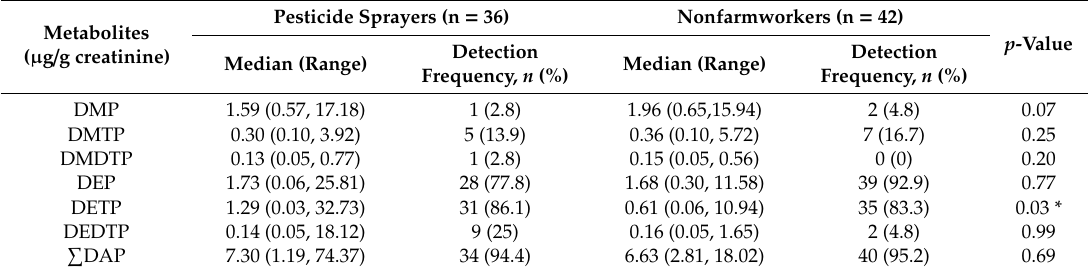
Table2. DAPlevels( µ g / gcreatinine)anddetectionfrequencyinpesticidesprayersandnonfarmworkers. Metabolites ( µ g / g